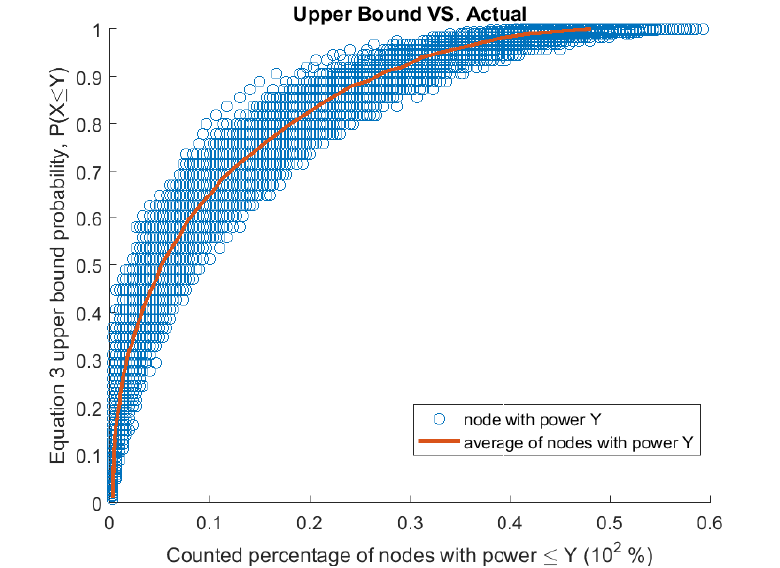
Figure 2. Plotting 10,000 random WRSNs. Each point is a node with residual power Y . For each node, the actual percentage of nodes with power ≤ Y ( x -axis) vs. the computed bound ( y -axis) are plotted. Each point in Figure 2 represents counted and computed probability for a power level to